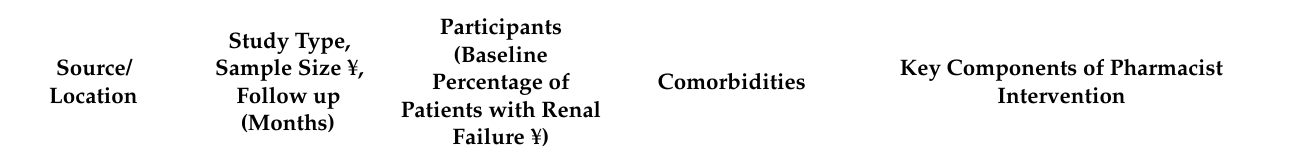
Measured Outcomes (Intervention vs. Usual